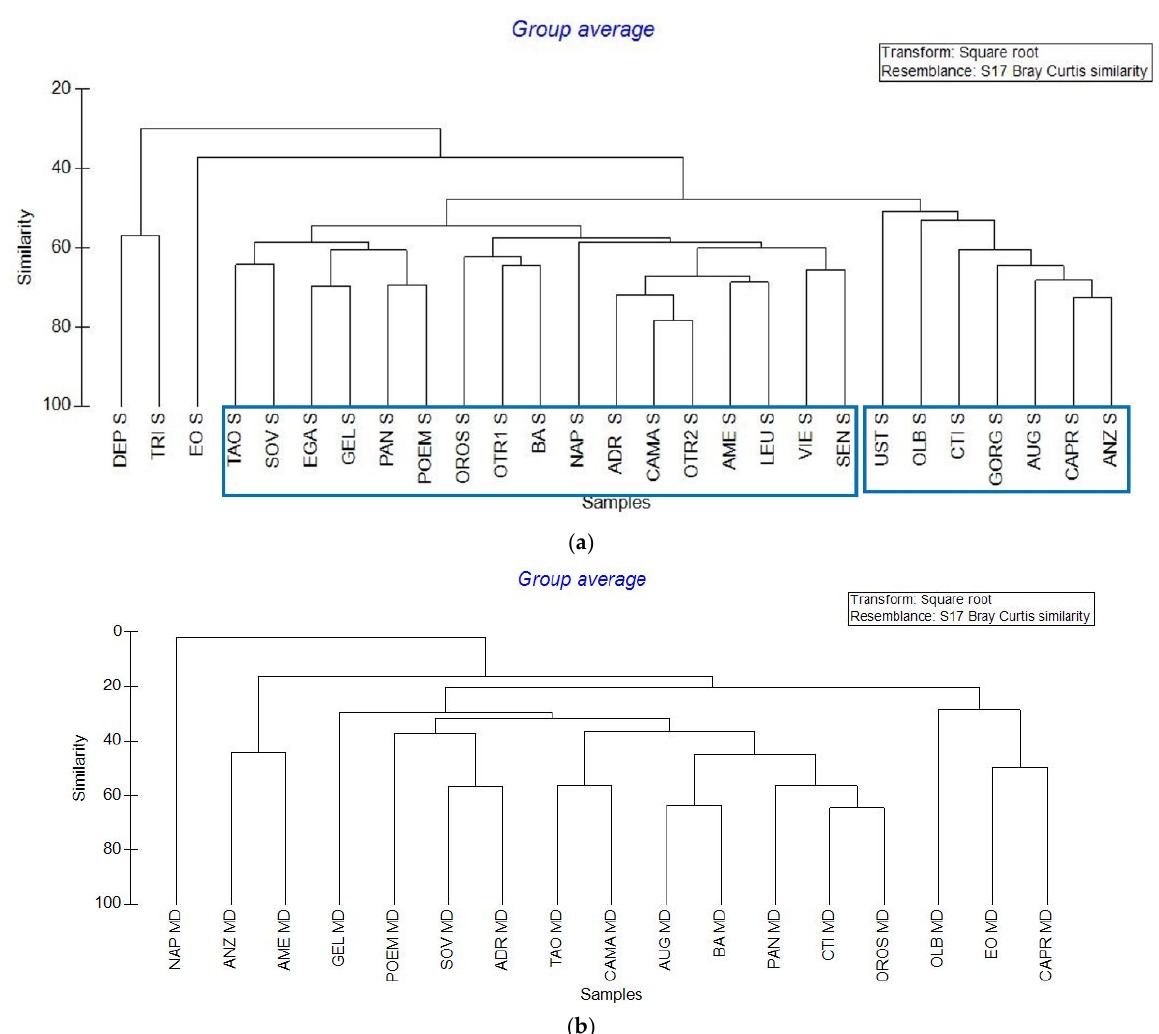
Figure 8. Cruise 2017. Representation of hierarchical cluster. ( a ) Epipelagic (surface) samples from 27 stations; ( b ) Mesopelagic (200–500 m) samples from 17 stations.